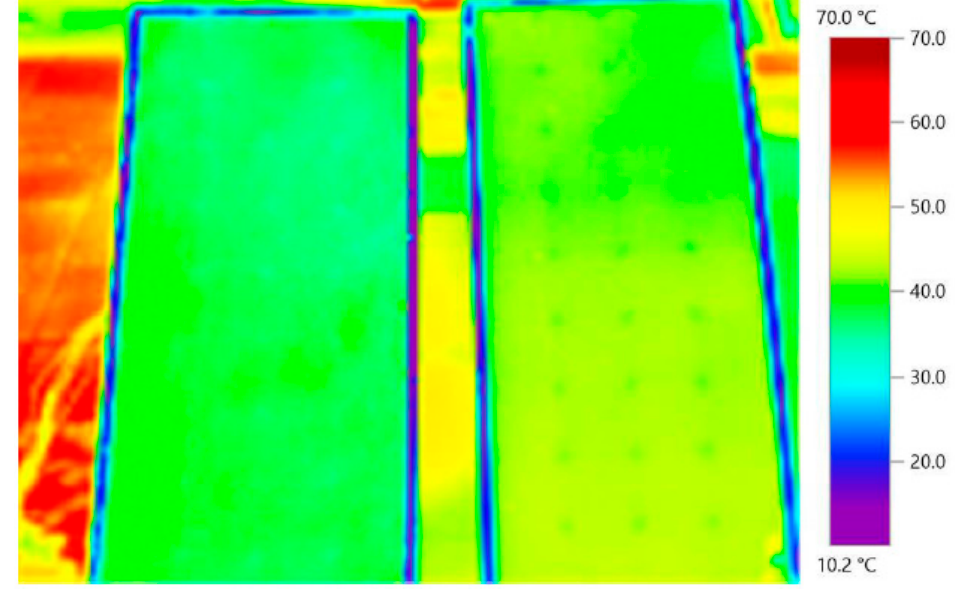
Figure 8. Thermal image for the cooled panel (left) referenced panel (right).